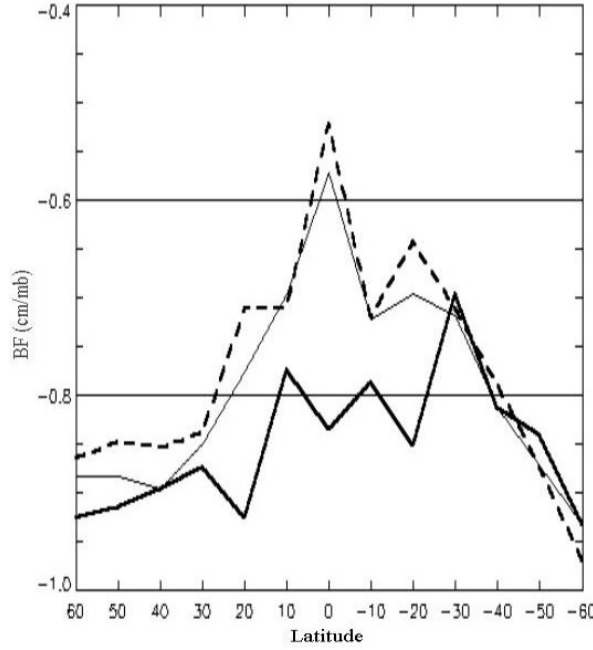
Fig. 2. Meridional distribution of the Barometric Factors ( BF ) esti- mated using ERS-2 altimeter records, in the Atlantic Basin, consid- ering the three different time samplings used: 35 days (gross solid line), 11 days (thin solid line) and 4 days (dashed